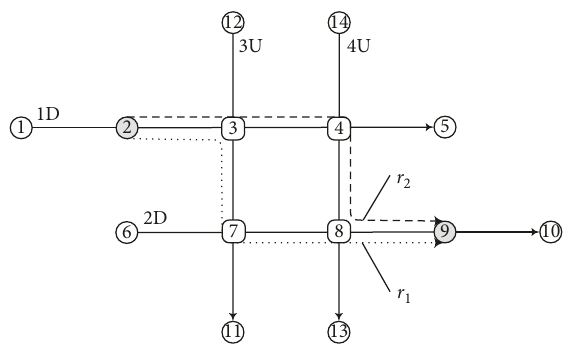
Figure 1: Illustration of the metro network and passenger transfer